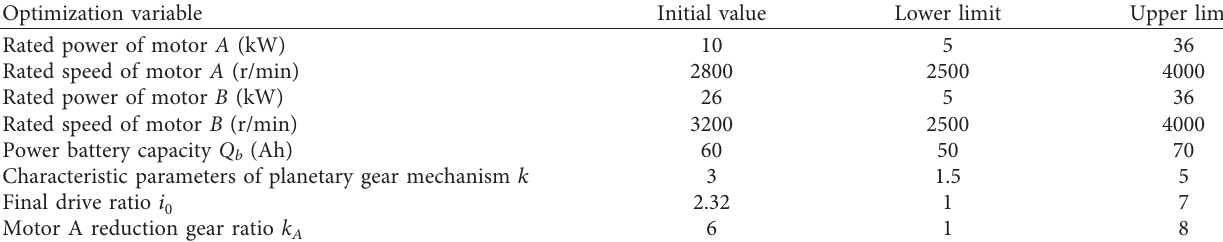
Table 2: Optimal variable boundary